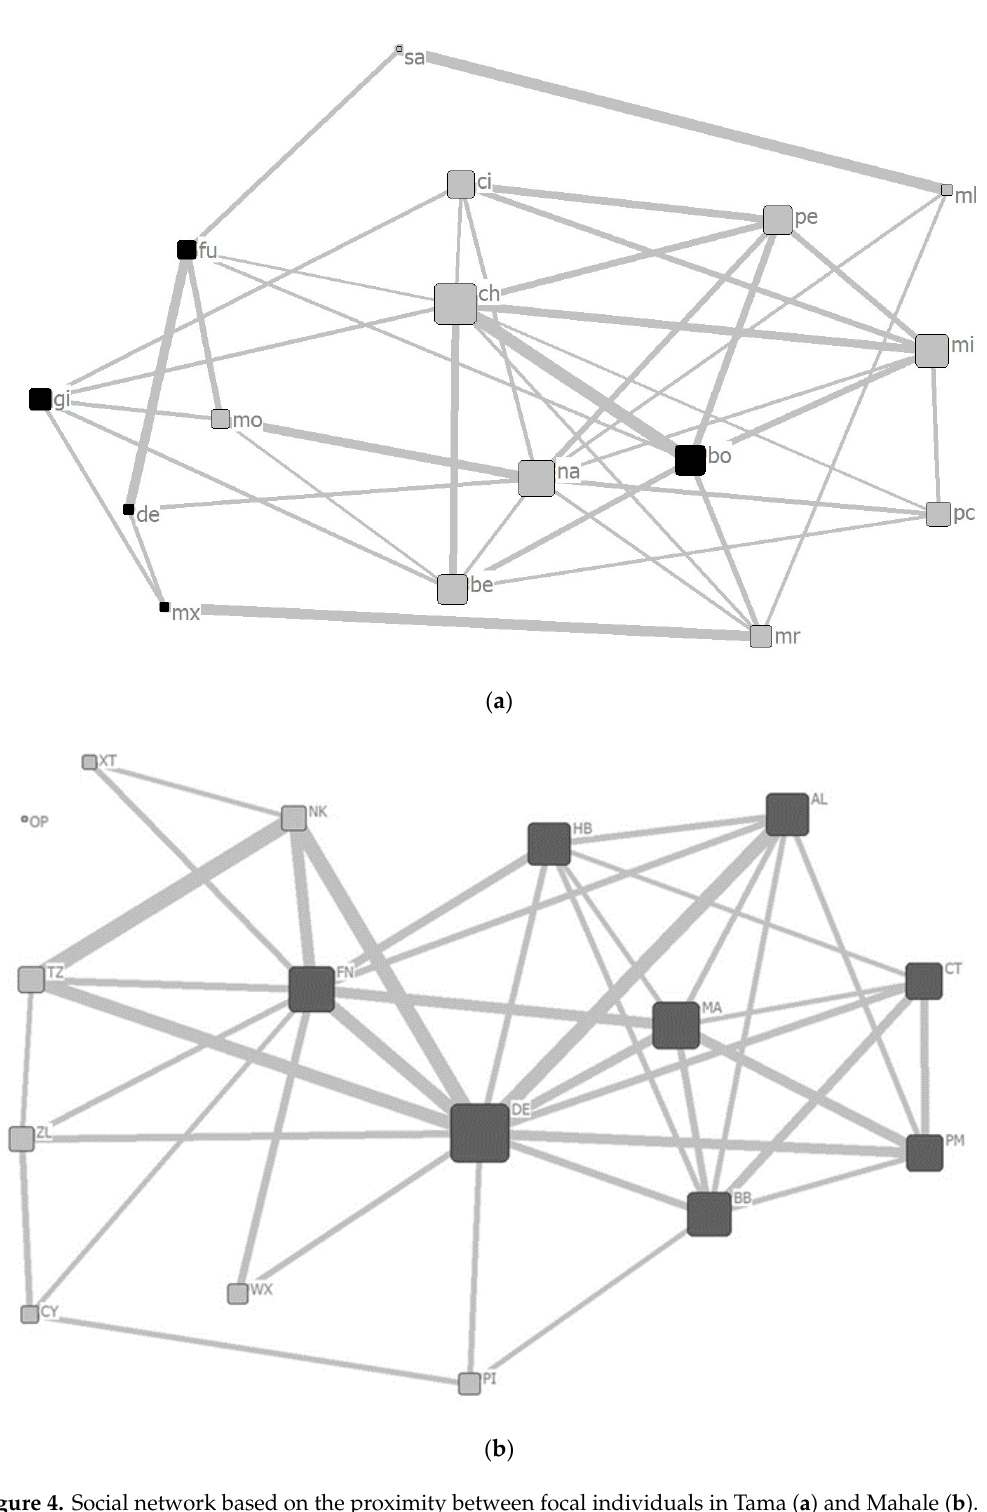
Figure 4. Social network based on the proximity between focal individuals in Tama ( a ) and Mahale ( b ). Black and gray squares represent males and females, respectively. The size of the square represents the value of the eigenvector centrality of each focal individual in the network. The thickness of the line is an indicator of the proximity index ( PI ) value between connected individuals. The abbreviation of each individual’s name is placed next to each